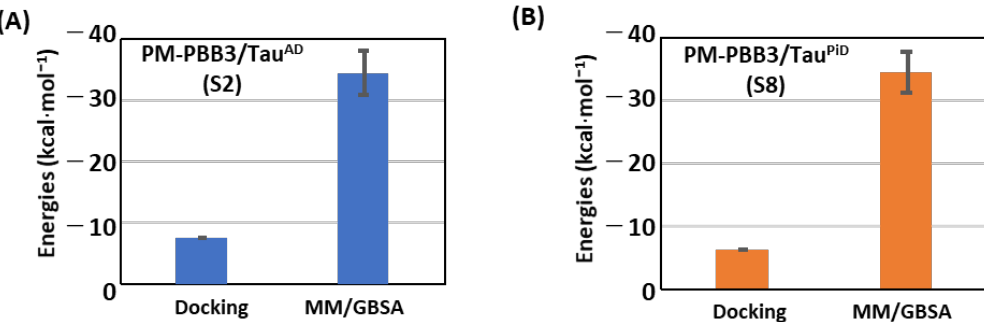
Figure 5. Docking scores and binding affinities of PM-PBB3 in Tau AD ( A ) and Tau PiD ( B ). Standard deviation in MM/GBSA binding energy over all snapshots is shown as error bars.